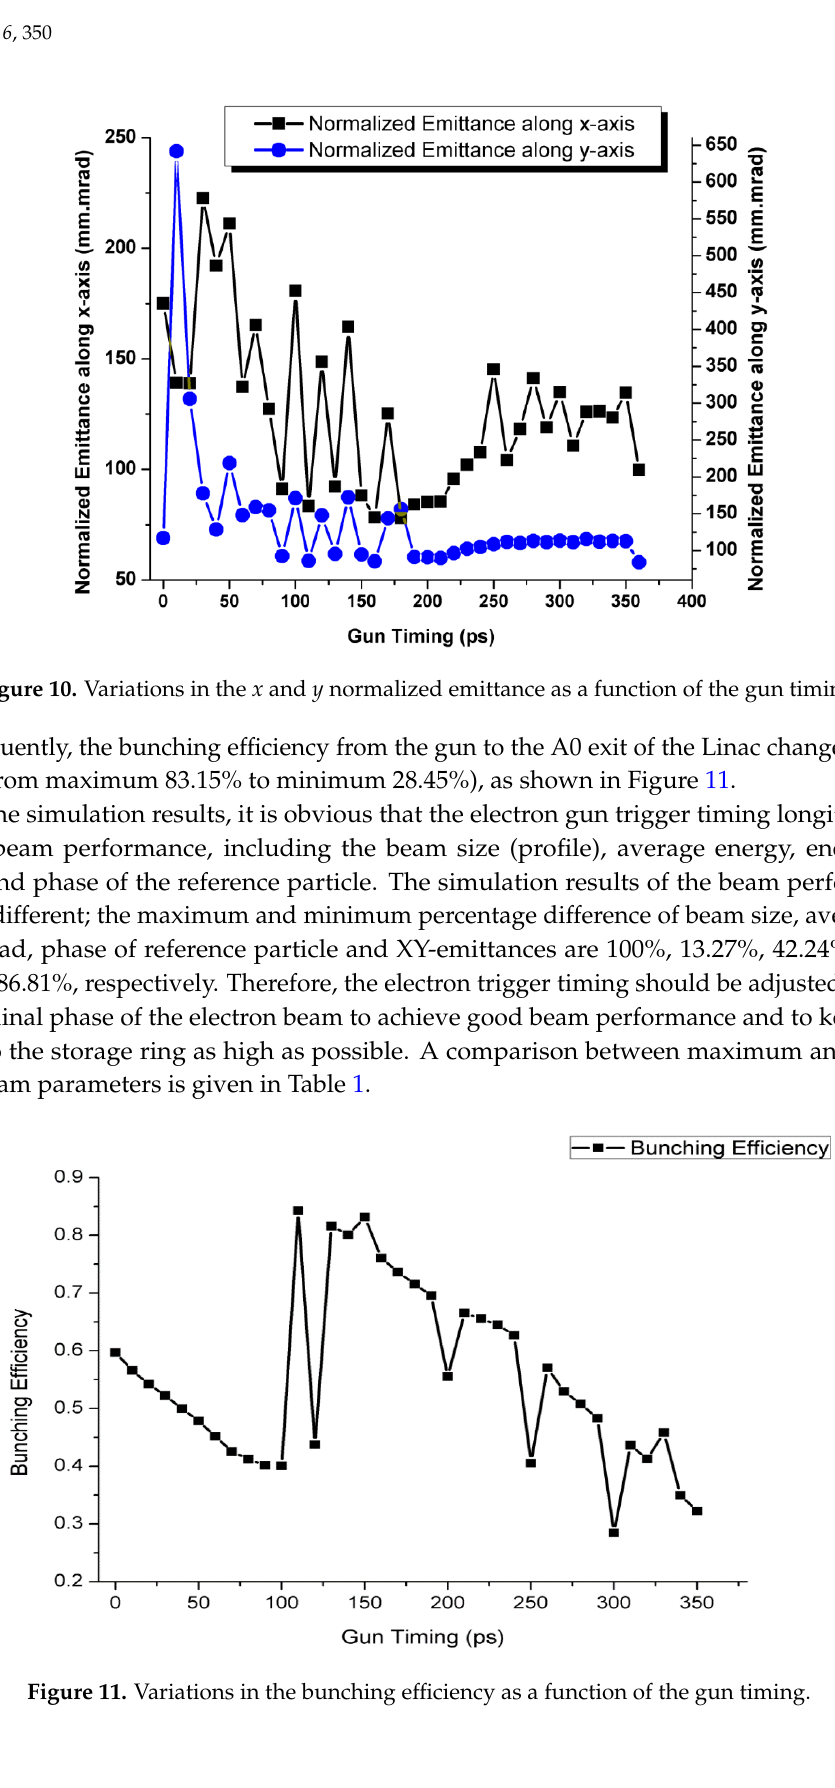
Figure 9. Variations in the beam energy, energy spread, and phase as a function of the gun timing.